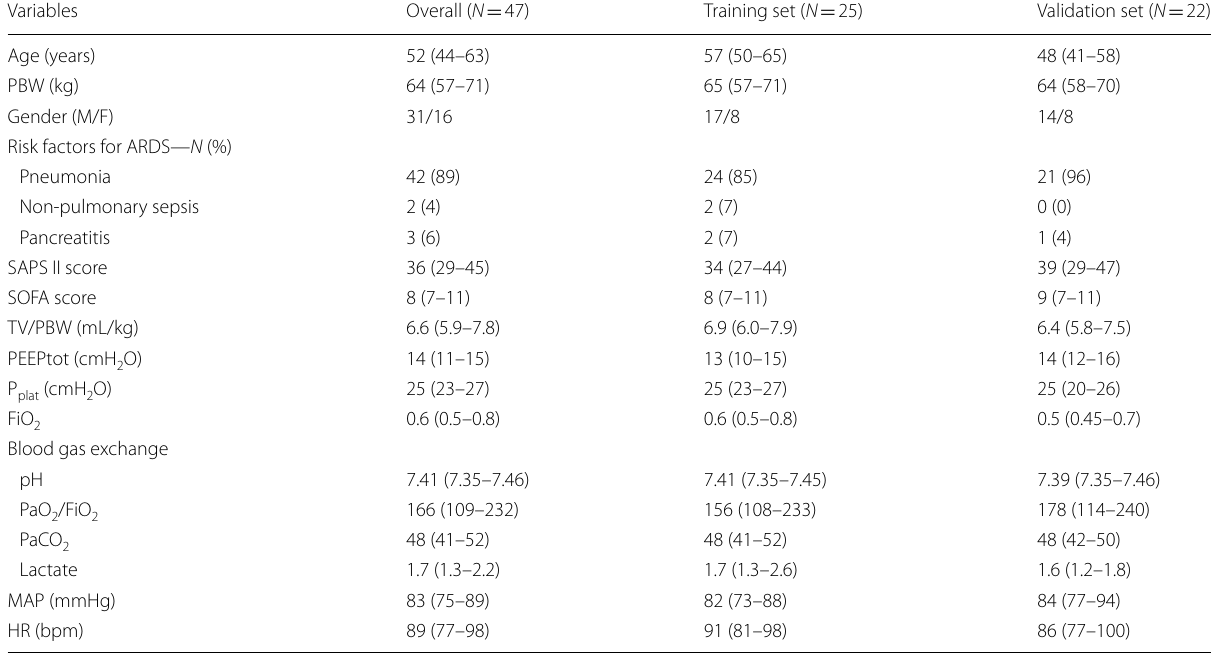
Table 1 Baseline characteristics of the study population patients, ventilation settings, blood gas exchange and hemodynamic